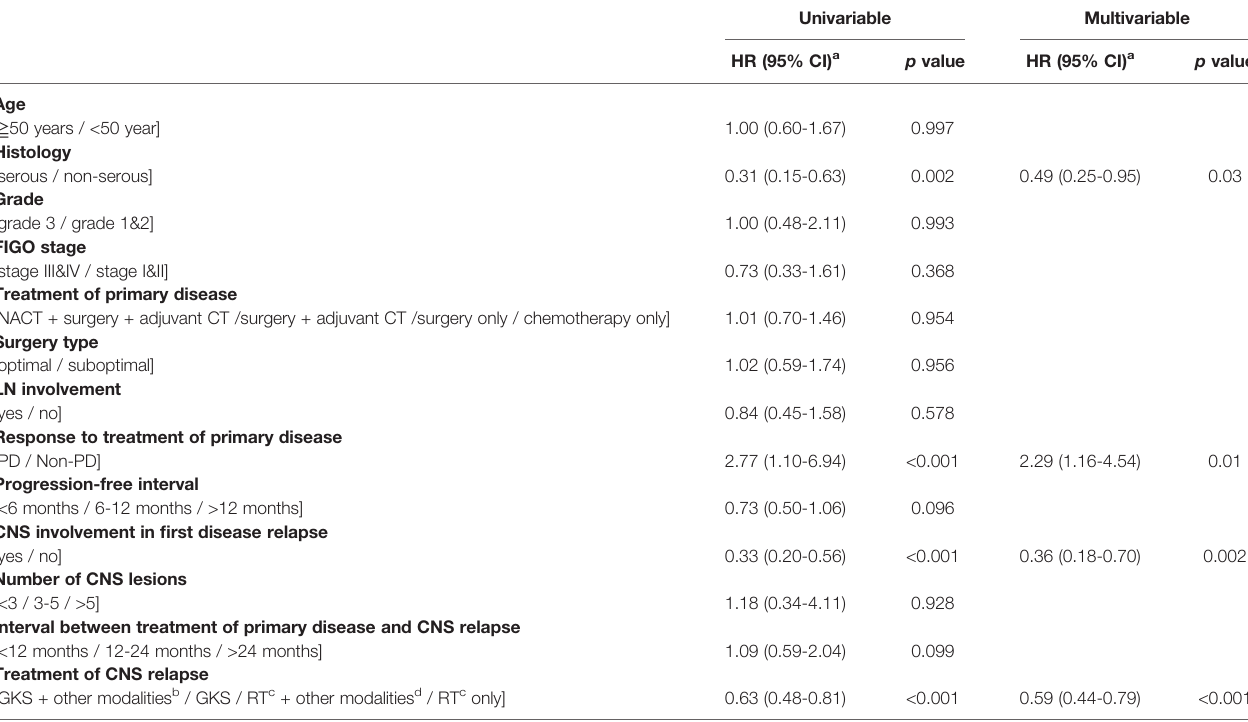
TABLE 3 | Univariable and multivariable analysis of prognostic factors affecting survival from CNS